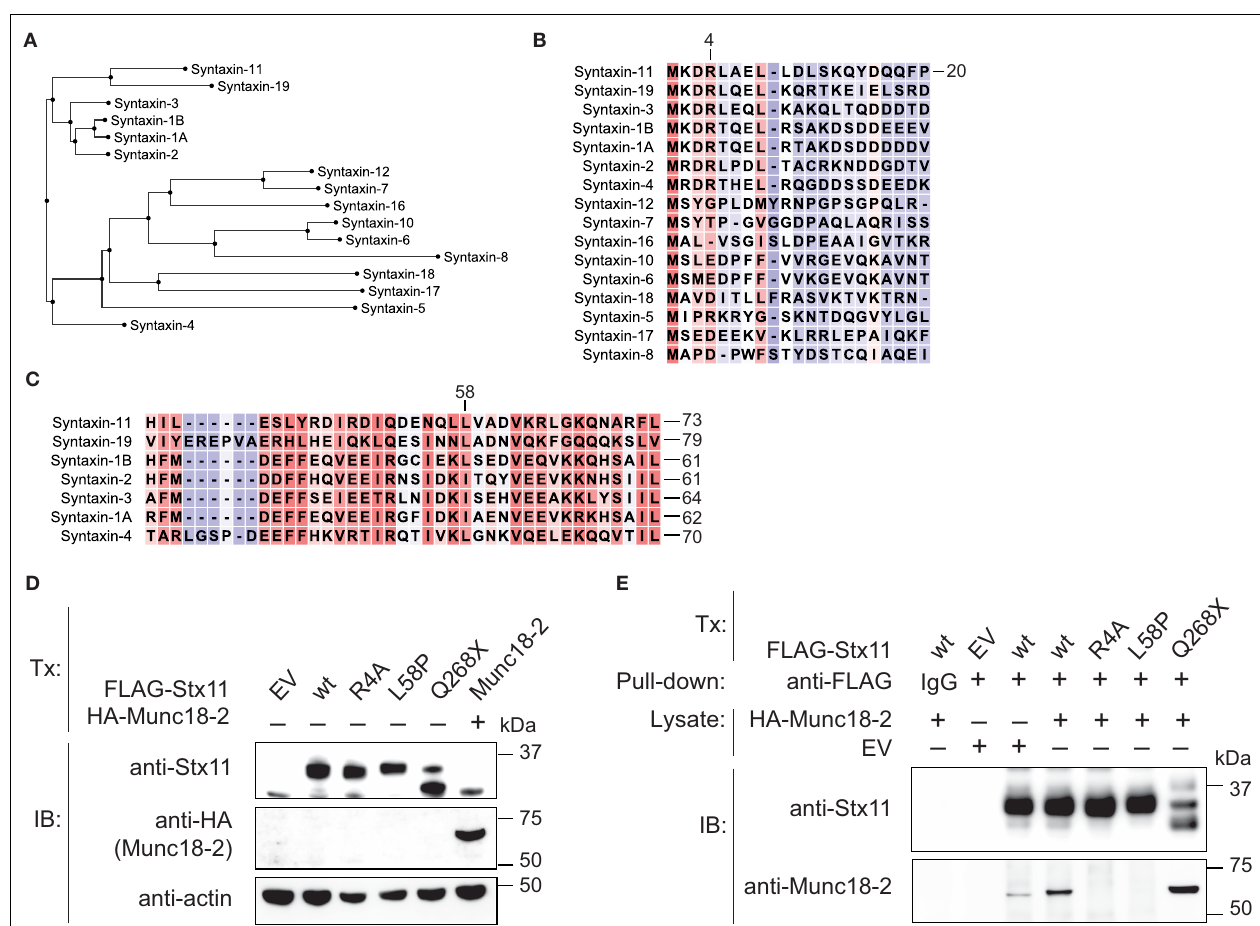
FIGURE 4 |Abrogated binding of Munc18-2 to syntaxin-11 N-terminal R4A or Habc-domain L58P mutations . (A) Dendrogram comparing human syntaxins based on peptide sequence alignments of the N-termini (N-peptide and Habc domain; residues 1-167 of Stx11). (B) Amino acid alignments of human syntaxin (B) N-terminus and (C) Habc domain sequences. Red shade indicates a high degree of sequence homology, whereas blue shade indicates low homology. (D) HEK-293T cells were transfected with empty vector (EV), or constructs encoding FLAG-Stx11 wild-type (wt), R4A, L58P, Q268X, or